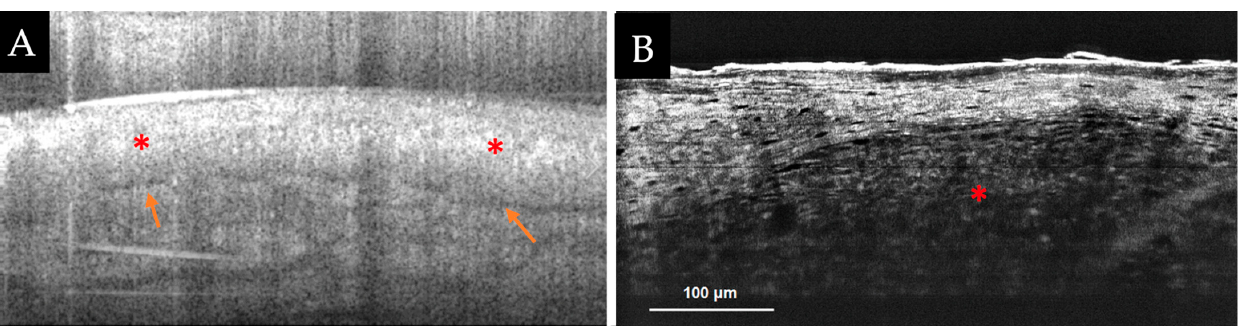
Figure 3. ( A , B ) Optical coherence tomography (OCT) images of tumor nodules (red asterisks) with clefting (orange arrows) from the BCC shown in Figure 1A acquired with ( A , at left) an RCM-OCT probe, and ( B , at right) high-resolution OCT device. Field of view: ( A ) = 2 × 1 mm; ( B ) = 500 × 400 µm. Images ( A , B ) courtesy of Ms. Rozina Zeidan, Clinical Research Specialist, Memorial Sloan Ket- tering Cancer Center.